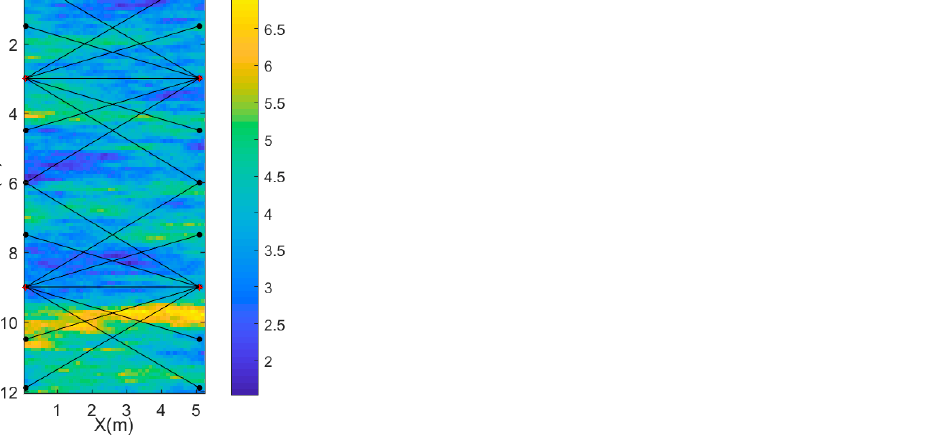
Figure 3. Noise-free waveforms and noisy waveforms: the signal-to-noise ratios from the top are 8, 15, 24, 32 and 40, respectively.